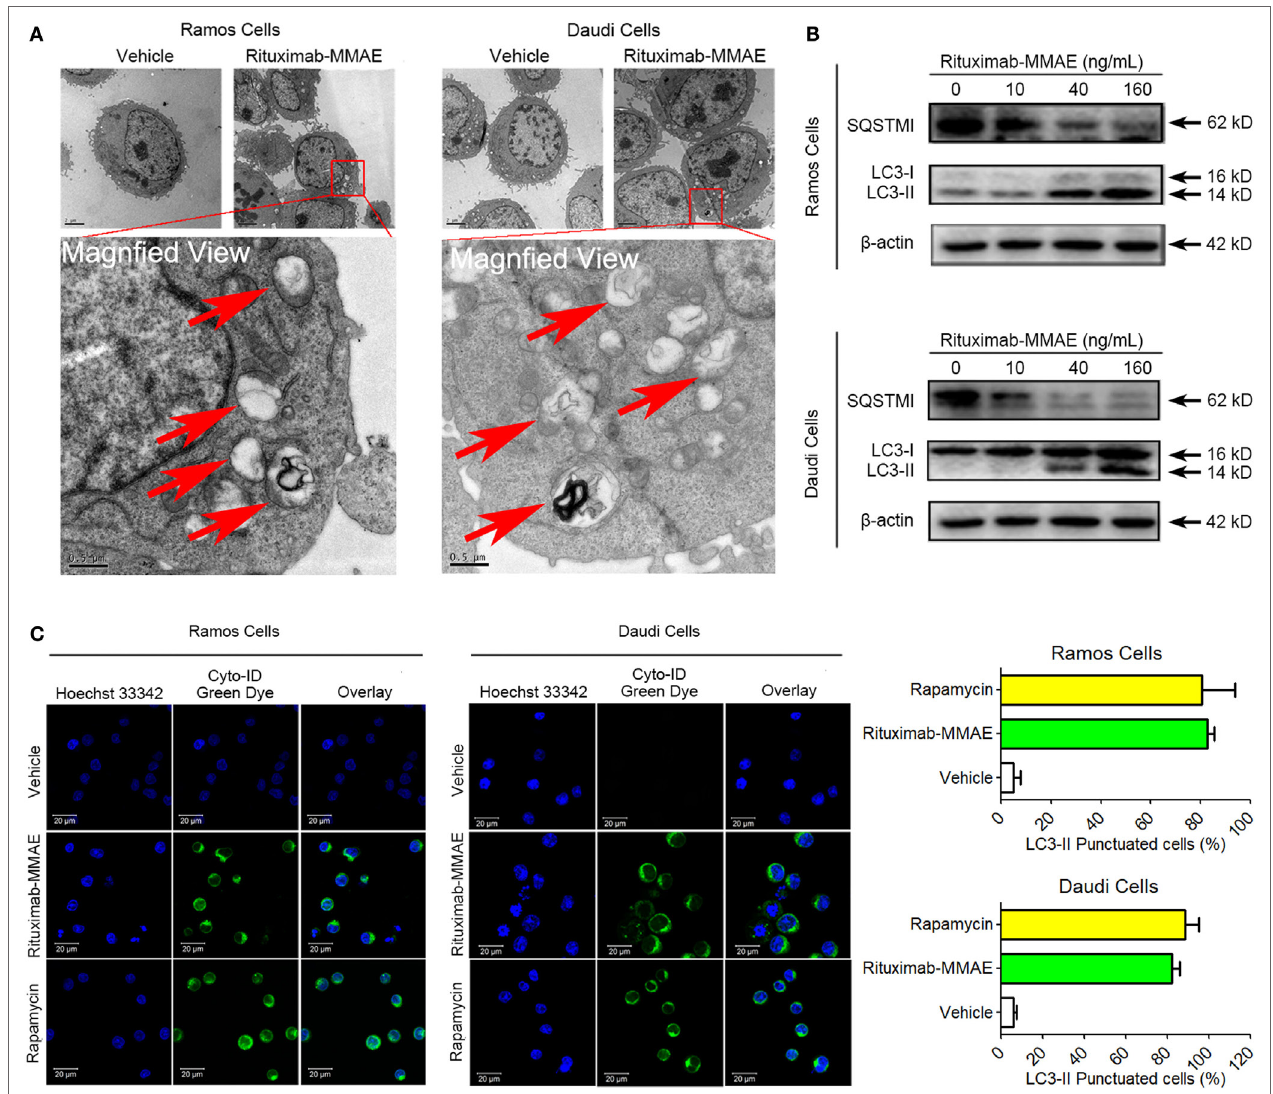
FigUre 3 | Rituximab-monomethyl auristatin E (MMAE) treatment induced accumulation of autophagosomes. (a) Ultrastructural analysis of Ramos and Daudi cells treated with Rituximab-MMAE. (B) The protein level of light chain 3 (LC3)-II and SQSTM1, two autophagic markers, in Ramos and Daudi cells after treatment with Rituximab-MMAE for 24 h. β -Actin was used as a loading control. Densitometric values were quantified by Image J software. (c) Extensive accumulations of autophagosomes in Ramos and Daudi cells were detected by Cyto-ID staining; Rapamycin was acted as the positive control. Results were presented as means ± SD of three independent experiments (Student’s t -test, * P < 0.05 and ** P <